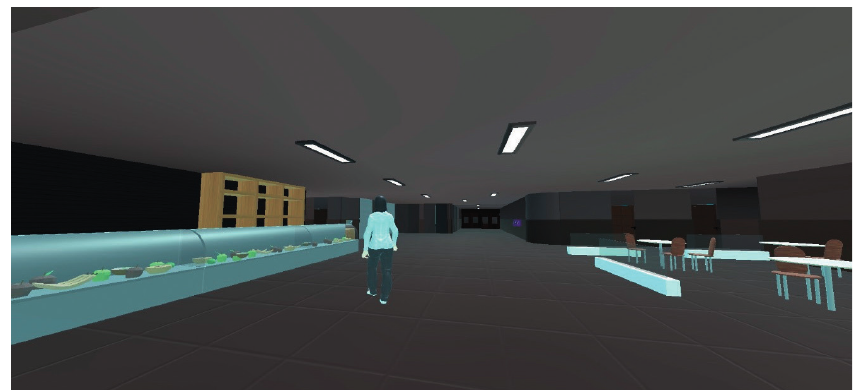
Figure 2. Participant's view of the avatar in Instructions phase of